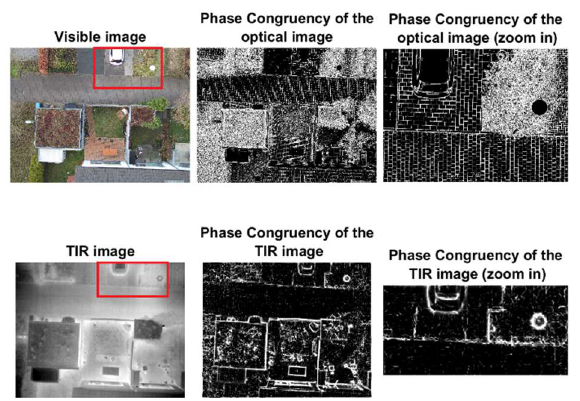
Figure 6. Phase Congruency of TIR and visible images with default parameters